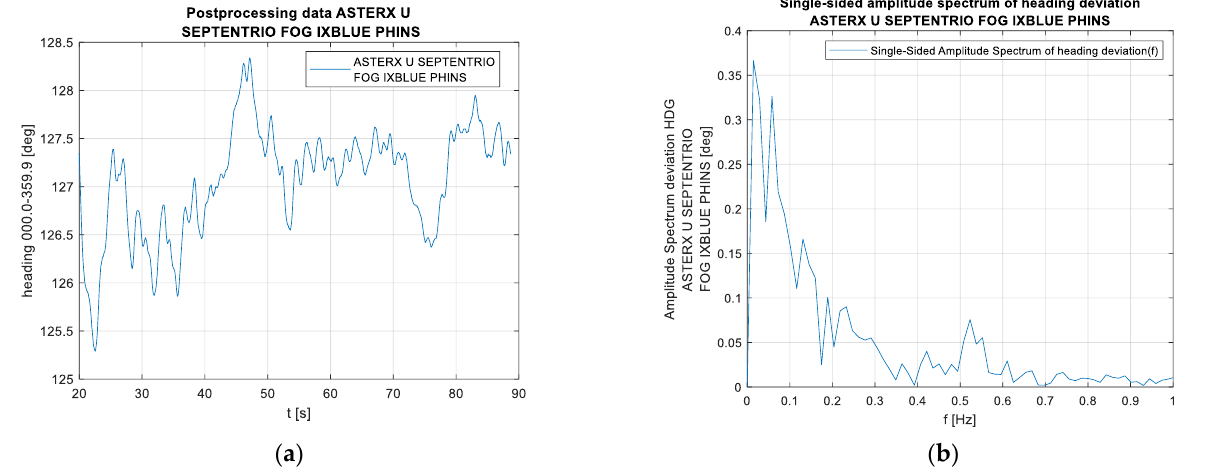
Figure 9. An example of a recording of the drone’s course and the amplitude spectrum of this recording: ( a ) the drone’s course in the time domain, and ( b ) the unilateral amplitude spectrum of the compass deviations in the frequency domain.